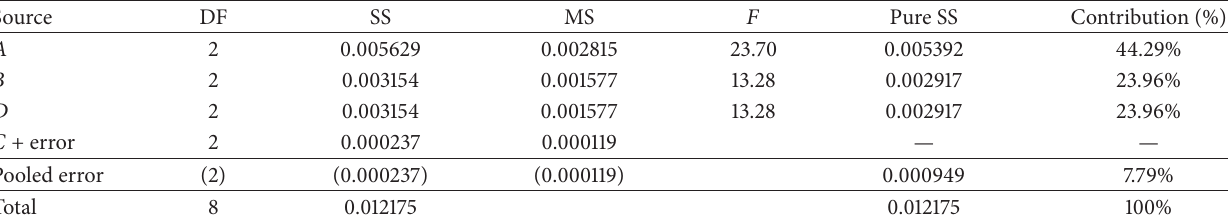
Table 6: Results of the analysis of variance for means.